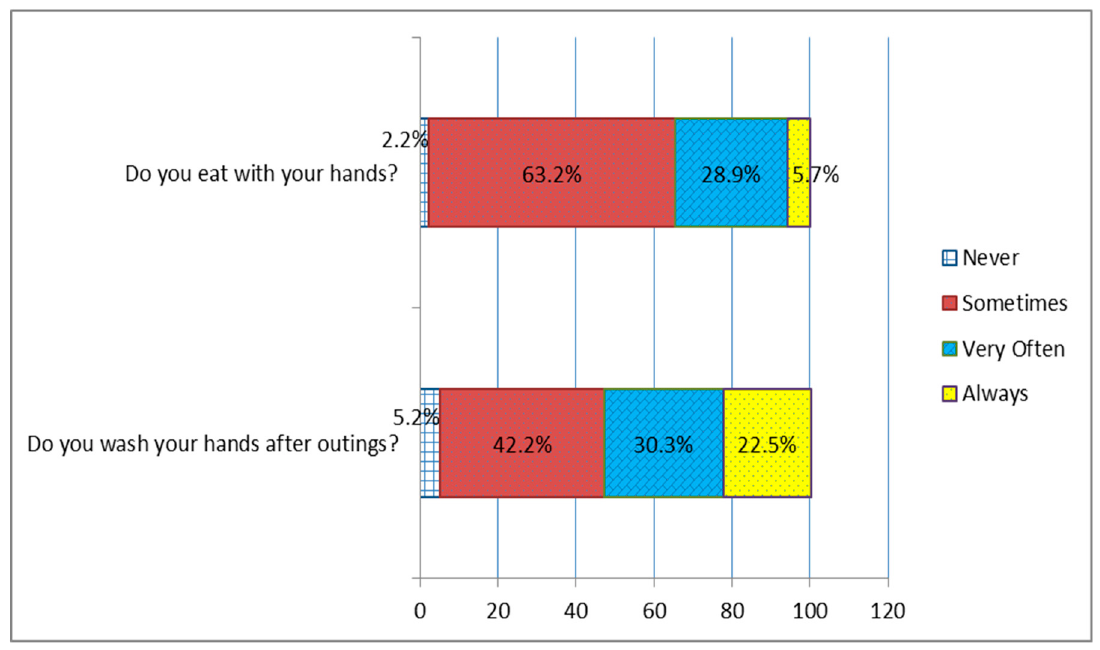
Figure 1. Diagram showing how often participants wash their hands after outings and how often they eat with their